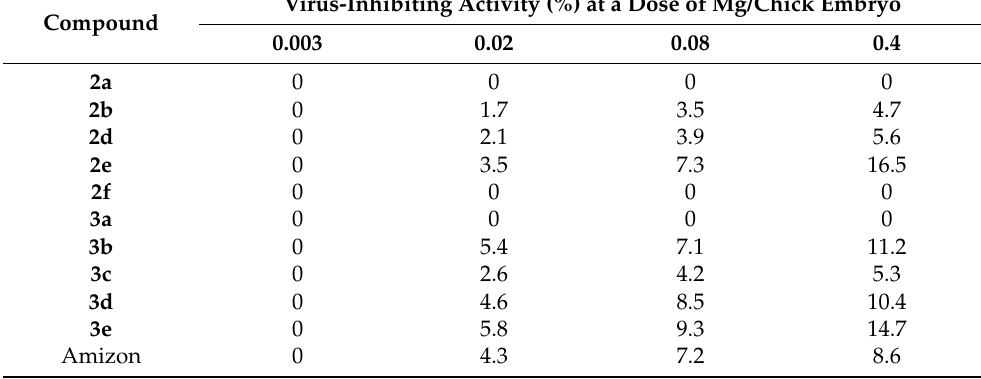
Table 2. Virus-inhibiting activity of the test compounds when exposed to a strain of avian influenza virus A/FPV/34/1 (H7N1).